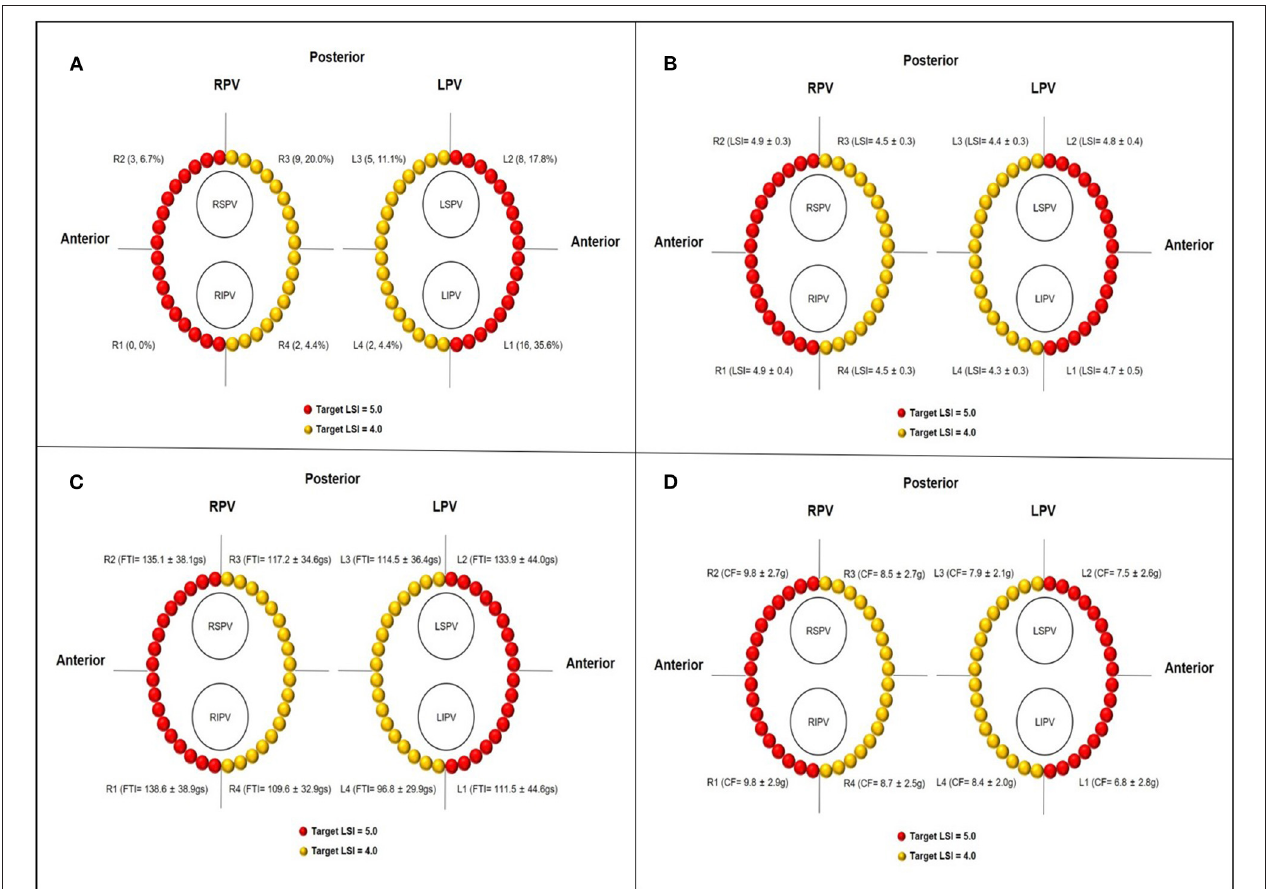
FIGURE 1 | (A) Schematic diagrams of target LSI at different PVs segments and distribution of conduction gaps after first-past PVI attempt. (B–D) The actual regional LSI, FTI, and CF at different PVs segments, respectively. LPV, left pulmonary vein; RPV, right pulmonary vein; LSPV, left superior pulmonary vein; LIPV, left inferior pulmonary vein; RSPV, right superior pulmonary vein; RIPV, right inferior pulmonary vein; L1 and R1, anterior inferior segments of LPV and RPV, respectively; L2 and R2, anterior superior segments of LPV and RPV, respectively; L3 and R3, posterior superior segments of LPV and RPV, respectively; L4 and R4, posterior inferior segments of LPV and RPV,